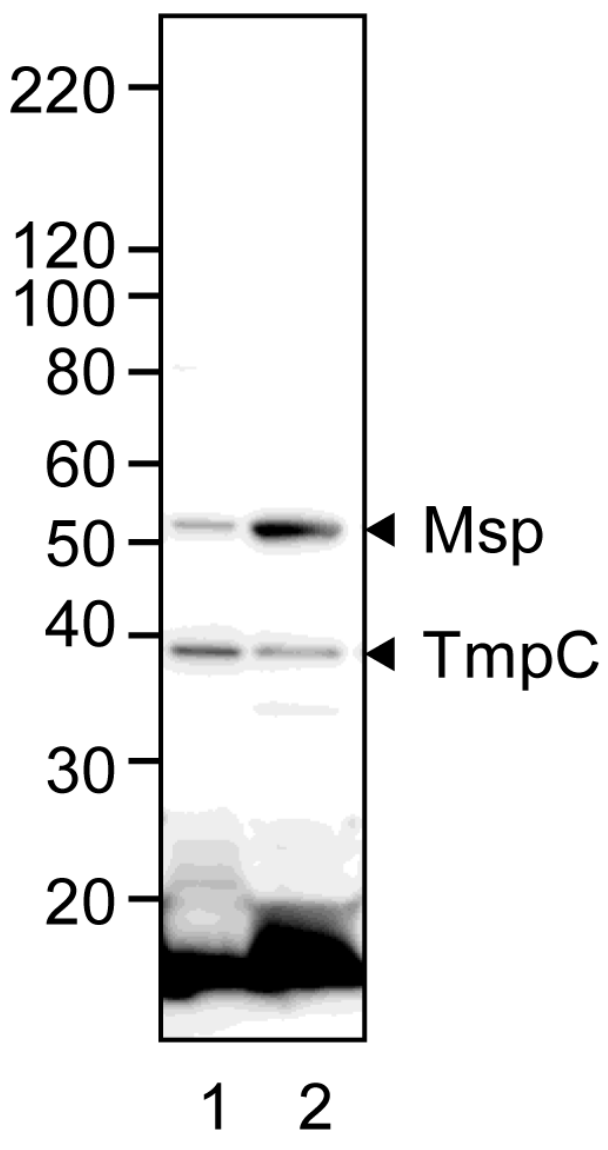
Figure 3. Cellular localization of TmpC and Msp proteins. T . denticola cells were fractionated into the insoluble (lane 1) and soluble fractions (lane 2) by suspending in 0.1% Triton X-100. The samples were applied to SDS-PAGE (5–20% gradient gel) followed by western blot analysis using anti- T . denticola antiserum. A molecular-weight standard (kDa) is shown at the